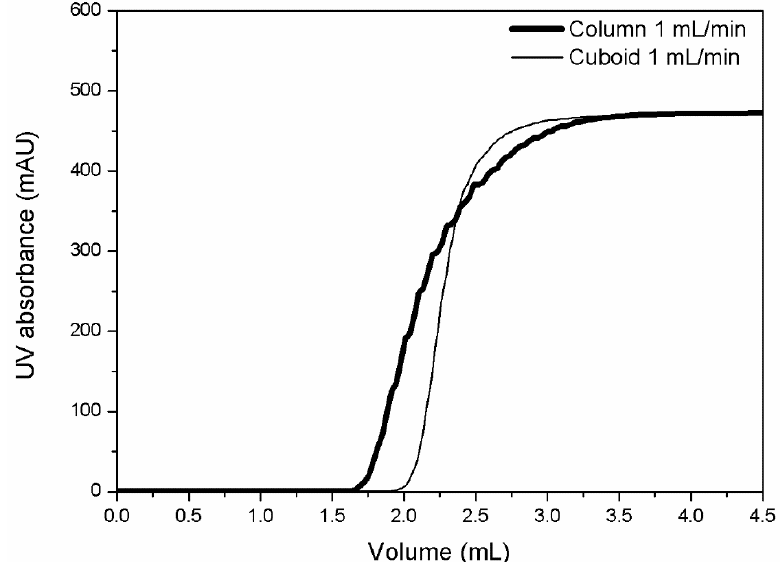
Figure 6. Unbound lysozyme breakthrough curves obtained with the best cuboid packed-bed device and its equivalent column (media: Capto Q anion exchange, bed volume: 5 mL, buffer: 50 mM Tris-HCl, pH